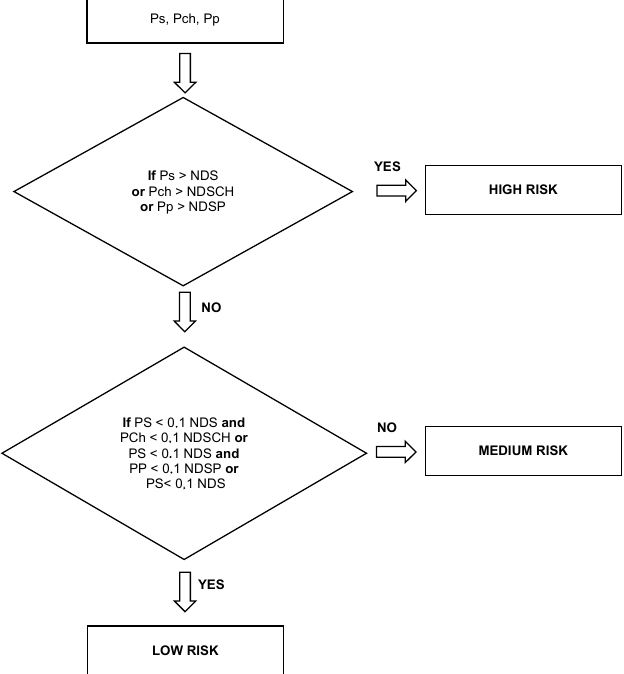
Figure 1. A three-step algorithm for estimating the risk associated with exposure to harmful chemical agents in the air during the production of